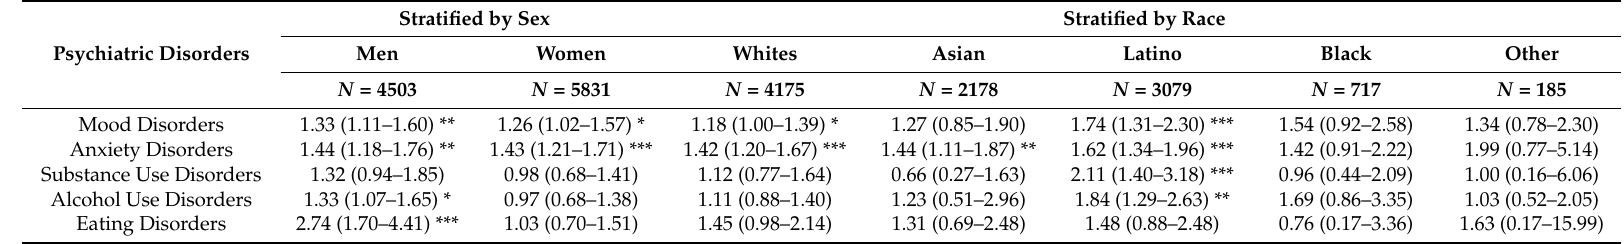
Table 3. Multivariable logistic regression models depicting the associations between lifetime seasonal allergies and lifetime psychiatric disorders, with effect modification by sex and